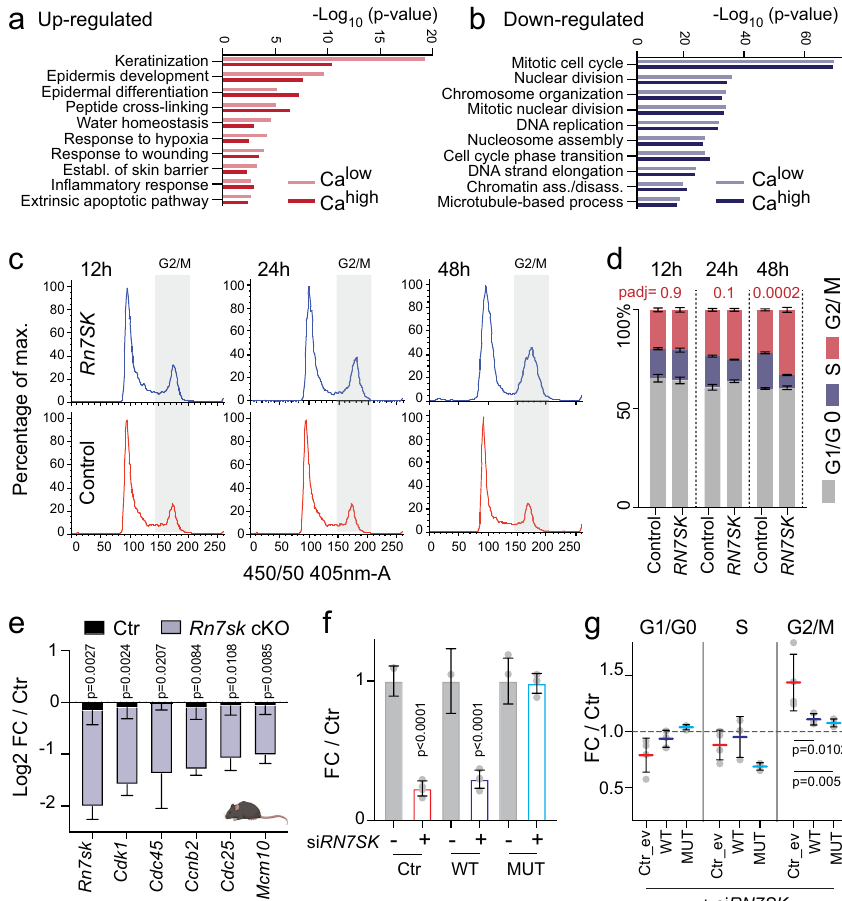
Fig. 7 Cell cycle exit causes differentiation in RN7SK-depleted epidermal cells. a , b Gene ontology analysis of up- (red; a ) or downregulated (blue; b ) genes (padj < 0.001; log 2 FC > or < 0.75) in response to RN7SK knock-down in human keratinocytes grown in calcium low (Ca low ; light bars) or high (Ca high ; dark bars) conditions. c , d Cell cycle pro fi les of primary human keratinocytes ( c ) and quanti fi cation of percent of cells in the different phases of cell cycle ( d ) after 12, 24, or 48 h in control or RN7SK siRNA treated cells ( n = 5 transfections). Data are presented as mean values ±SD. e RT-qPCR for fi ve cell cycle regulators in mouse epidermis of control (black) or RN7SK cKO (blue; mouse line 1) animals treated for 2 weeks with 4-OHT. f RN7SK levels after repression (si RN7SK ) in control empty vector (Ctr; red border) transfected cells or cells over-expressing wild-type (WT; dark blue border) or mutated (MUT; light blue border) RN7SK constructs in an epidermal cancer line (FaDu) ( n = 4 transfections). g Quanti fi cation of RN7SK -depleted cells in G1/G0-, G2/M- and S-phase of the cell cycle in the presence of an empty vector as control (Ctr_ev; red) or the wild-type (WT; dark blue) or mutated (MUT; light blue) RN7SK construct. ( n = 4 transfections). Shown is mean ±SD ( d – g ). Two-way ANOVA (multiple comparisons) ( d , f , g ). Multiple two-tailed